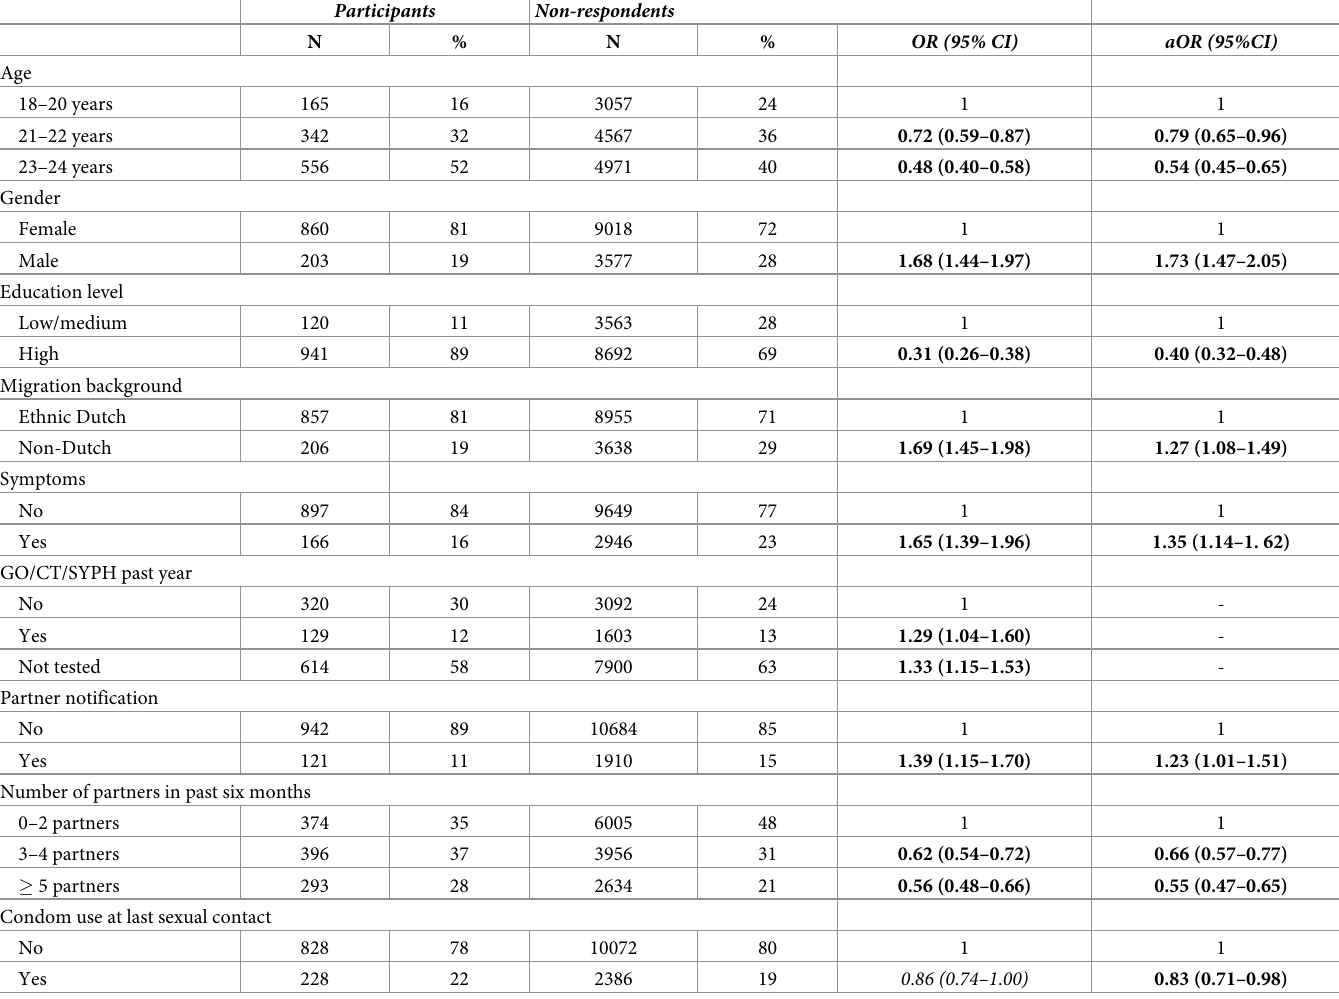
Table 1. Univariable and multivariable logistic regression analysis of predictors for non-response in the iMPaCT study by comparing participants (n = 1,063) and non-respondents (n = 12,595) aged 18–24 years visiting an STI clinic in November 2016 to June